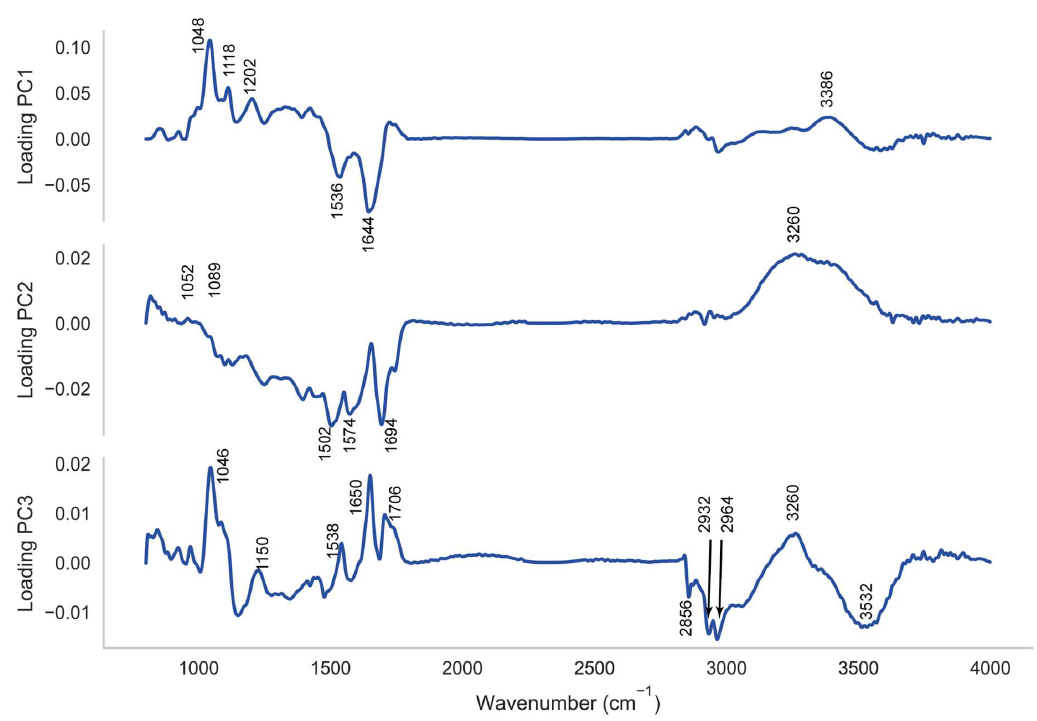
Figure 5. Loadings to the first three principal components for ( top ) analysis of PNT1A and ( bottom ) LNCaP PCA. Specific loadings of interest are highlighted.